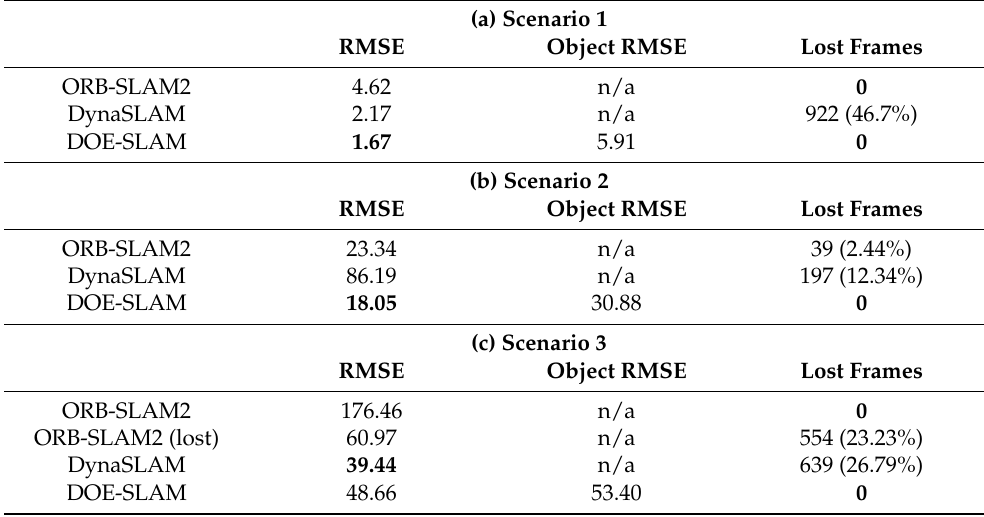
Table 1. Comparison of the RMSE of ATE (cm) for the camera and object, with the number of lost frames for three